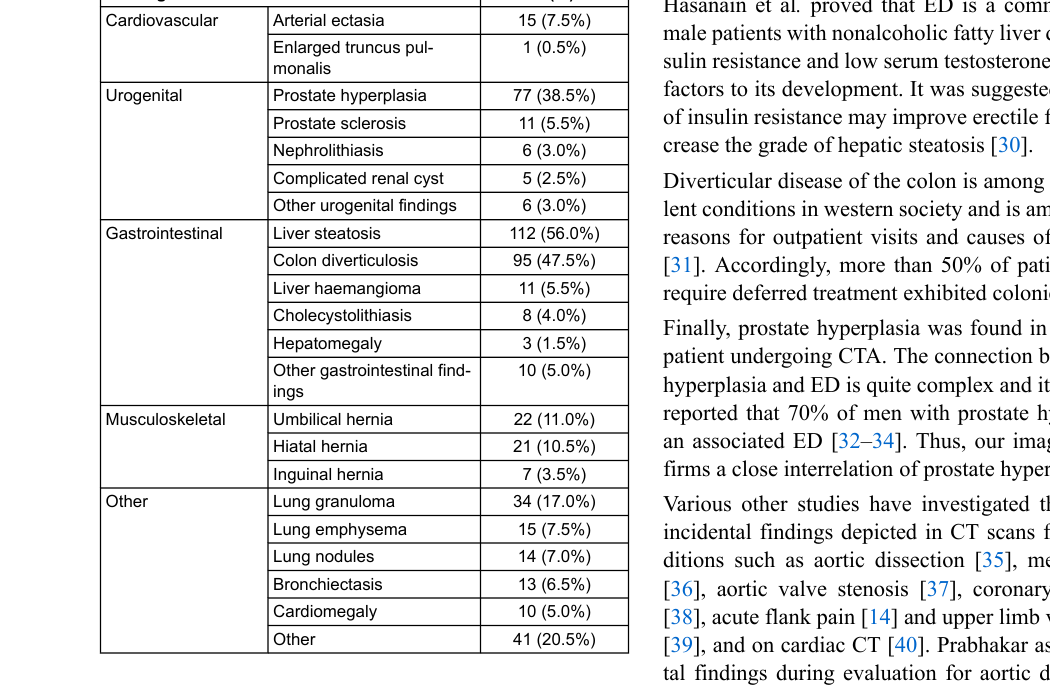
Table 4: Findings with little clinical importance in 117/200 patients with erectile dysfunction.